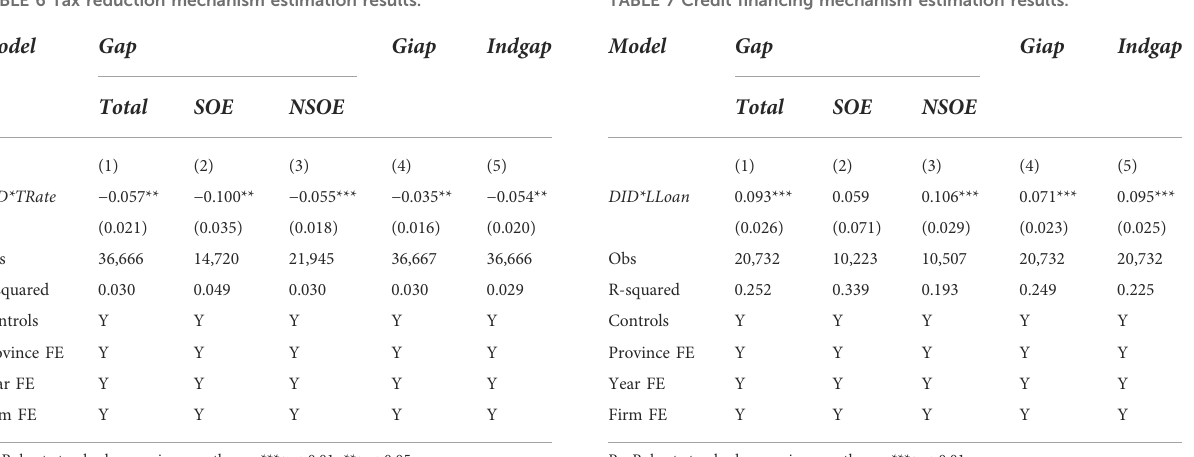
TABLE 7 Credit fi nancing mechanism estimation